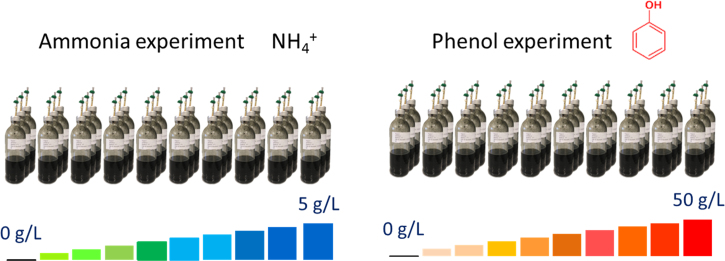
Experimental design.